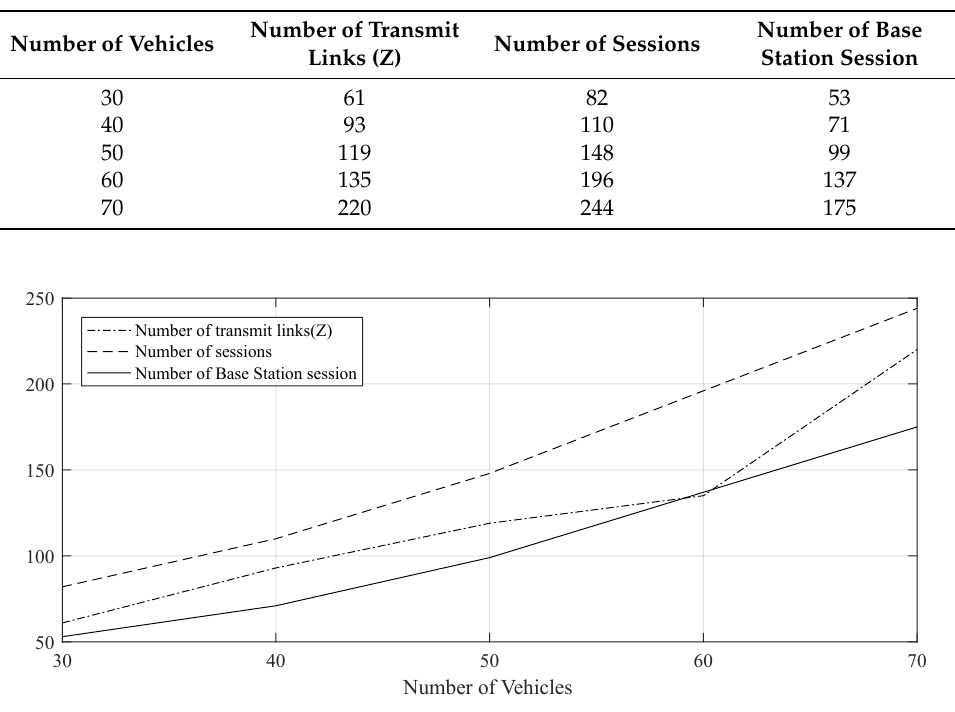
Figure 17. Number of Route Links and Sessions.